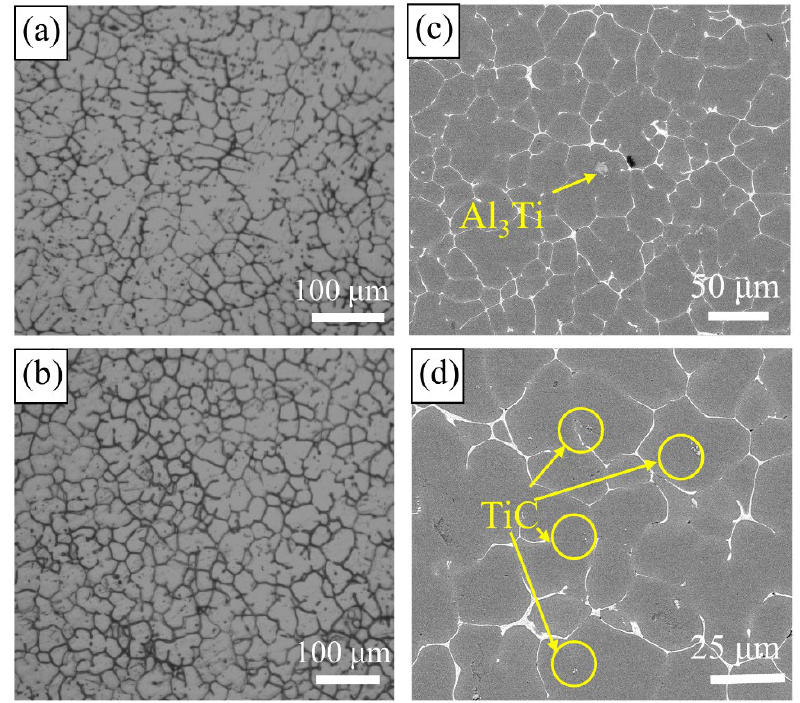
Figure 7. Microstructure of SC samples and UT-SC samples with 0.2 wt.% Ti: ( a ) OM image alloys with SC process; ( b ) OM image with UT-SC process; ( c , d ) different magnification of samples with UT-SC process.